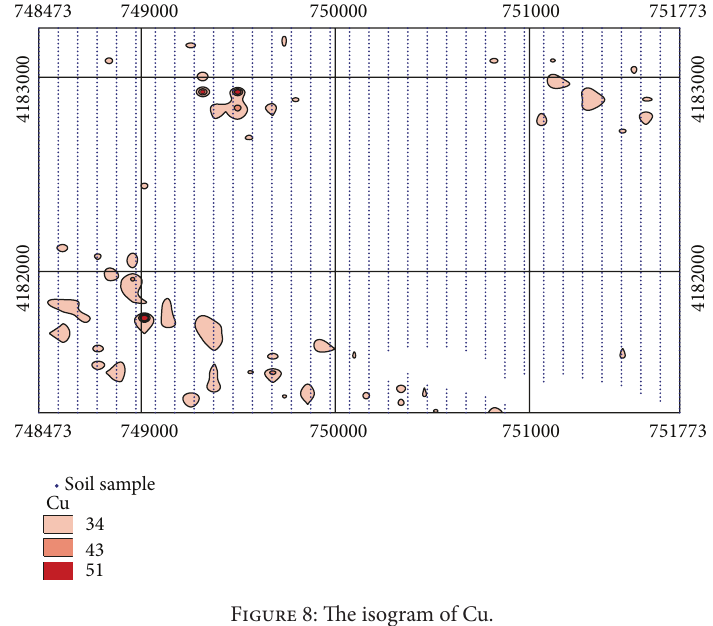
Figure 8: The isogram of Cu.